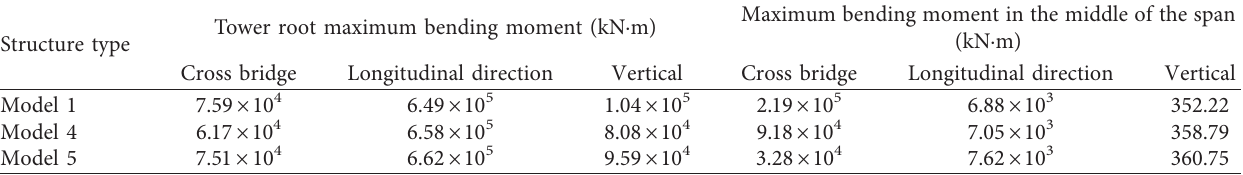
Table 14: Maximum bending moments of the tower root and midspan of the three structural models under longitudinal bridge direction +1/2 vertical excitation. Structure